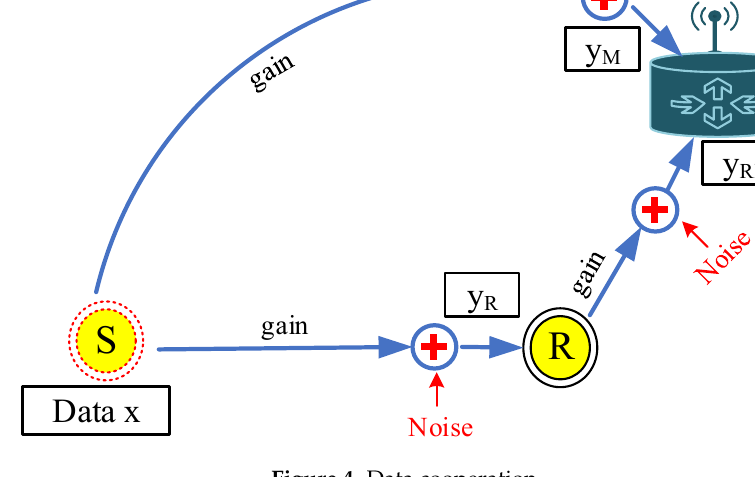
Figure 4. Data cooperation.